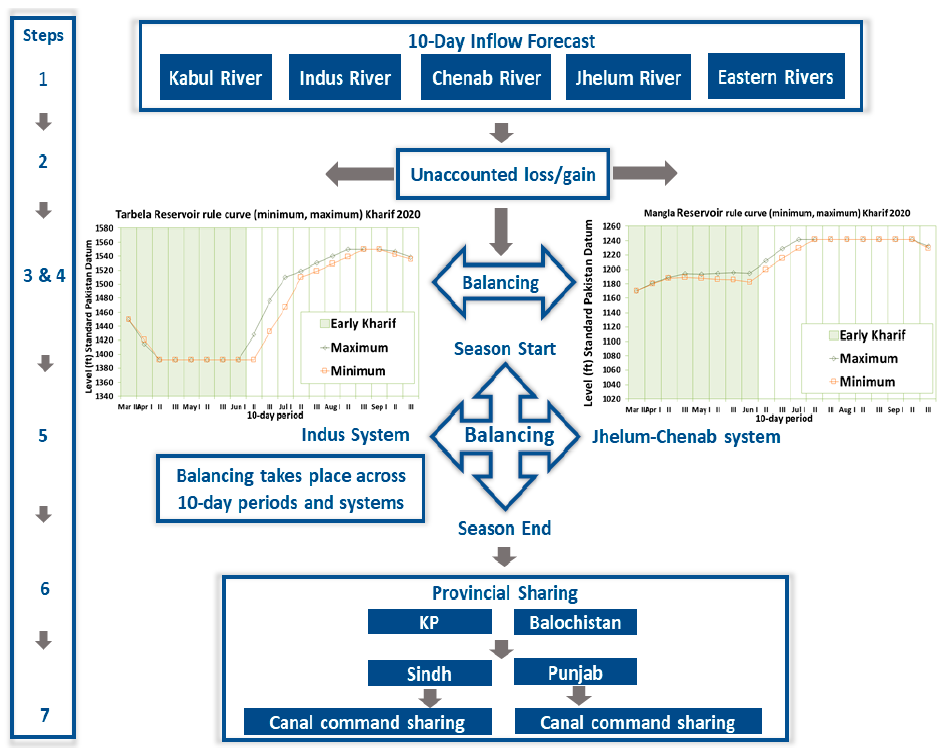
Figure 3. Schematic representation of seasonal water allocation planning in the J-C and Indus systems.